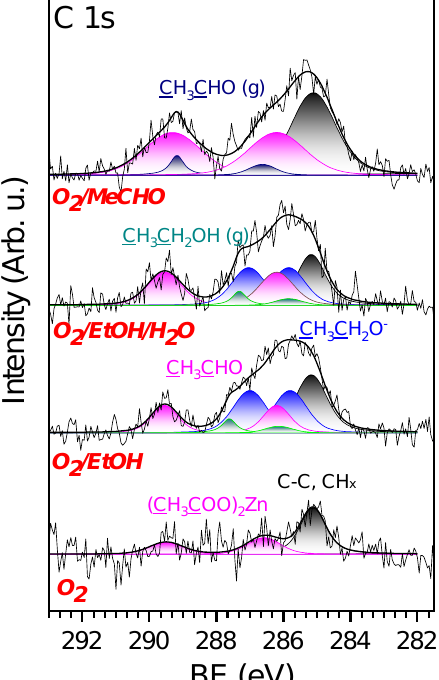
Figure 5. NAP-XPS spectra of the C 1s core-level acquired on the ZnO NRs-based sensor in the presence of O 2 , O 2 /EtOH, O 2 / EtOH/H 2 O and O 2 /MeCHO at 327 °C.